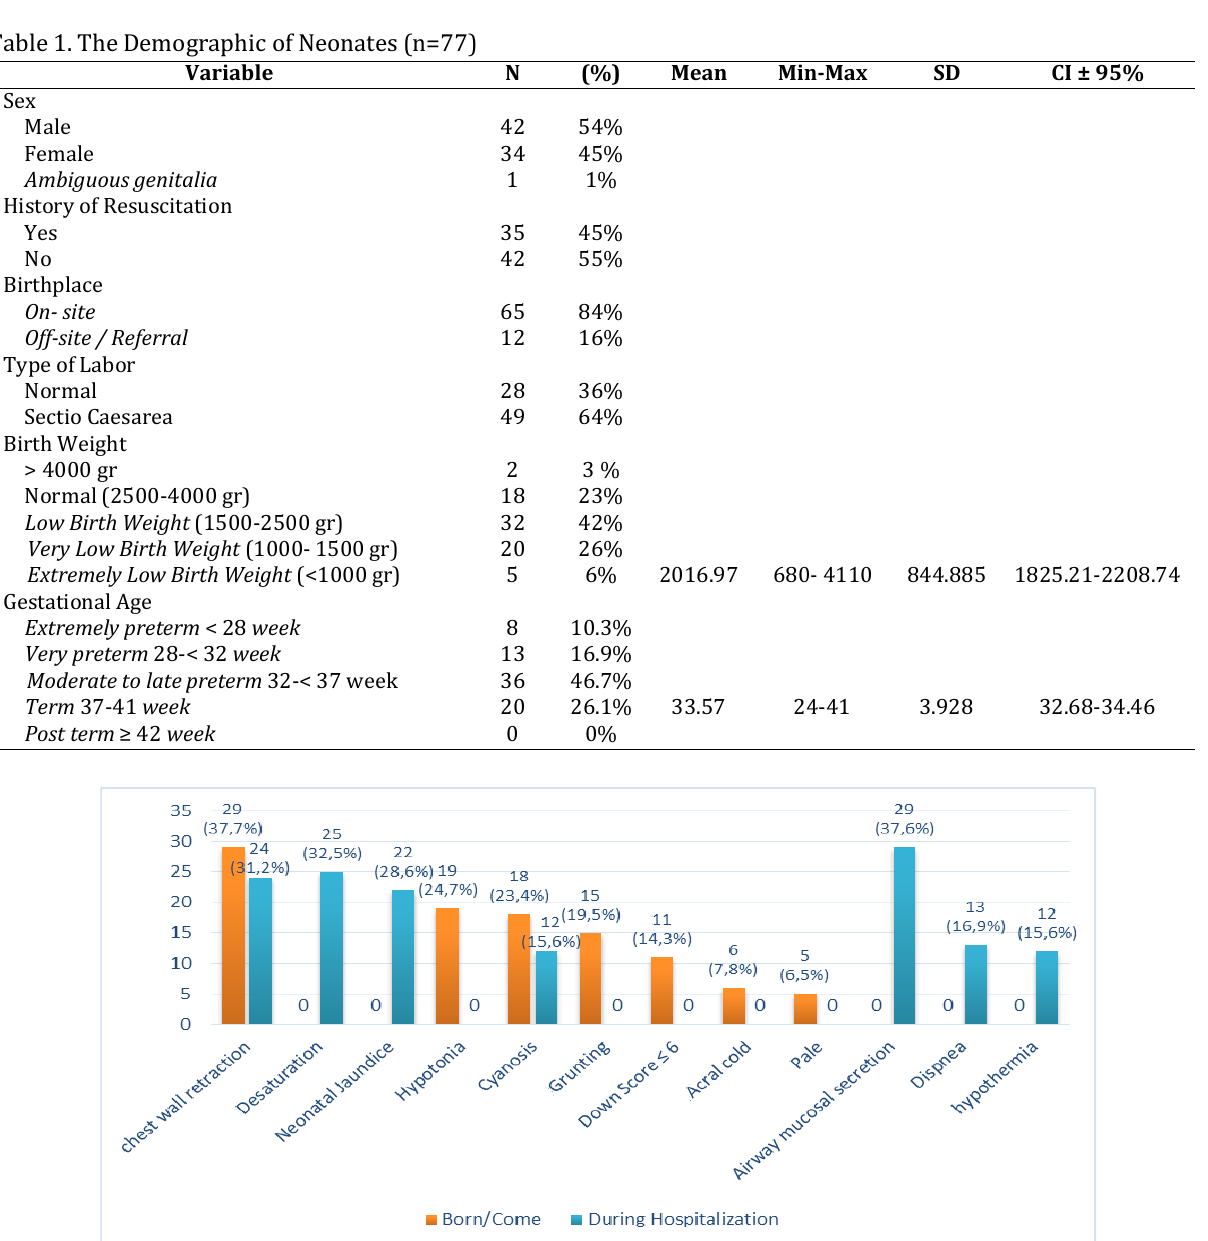
Figure 1. Signs and Symptoms of the Newborn at Birth and During